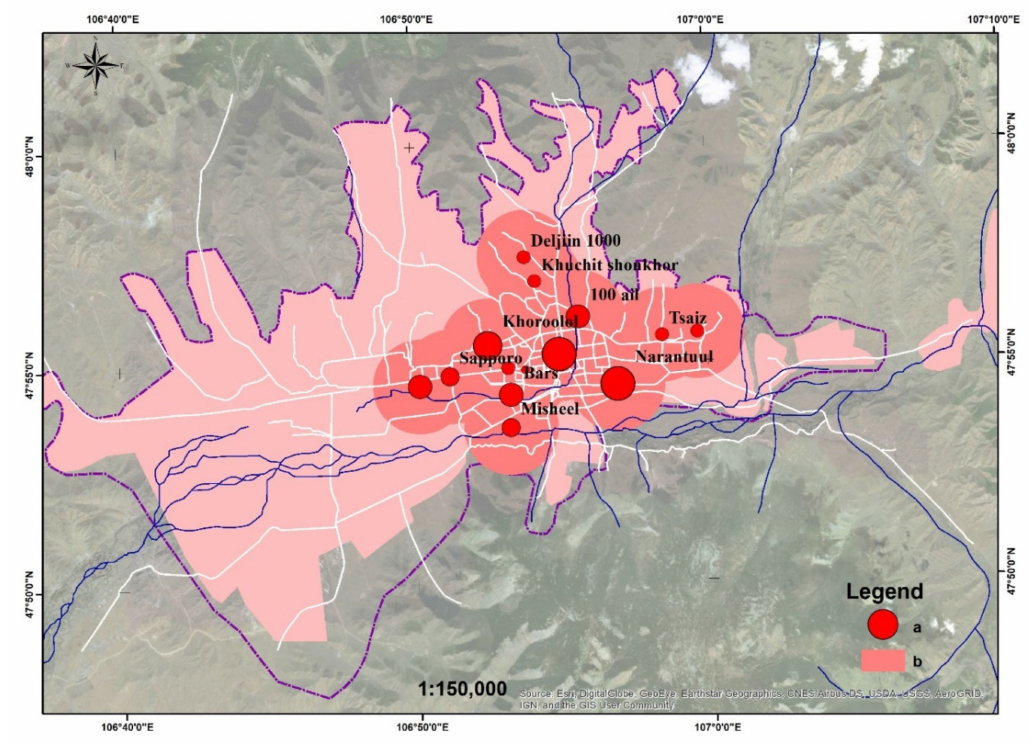
Figure 5. Map of the monocentric concept. ( a ) Population concentration points; ( b ) area suitable for